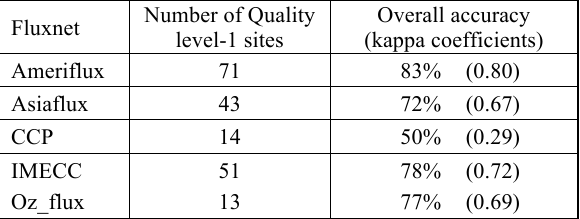
Table 6. The validation results of the MODIS IGBP global land cover products with quality-level reference data for each